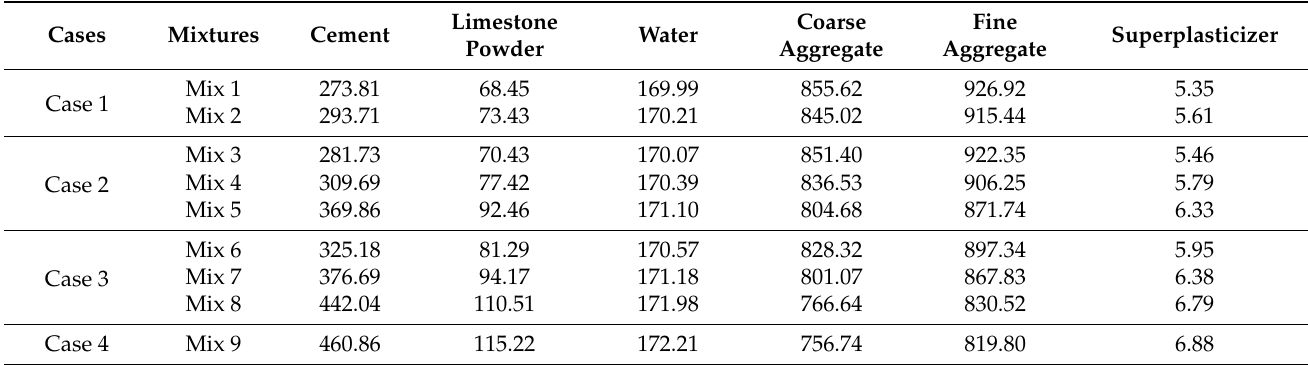
Table 5. Optimization mixtures of case studies (kg/m 3 ).